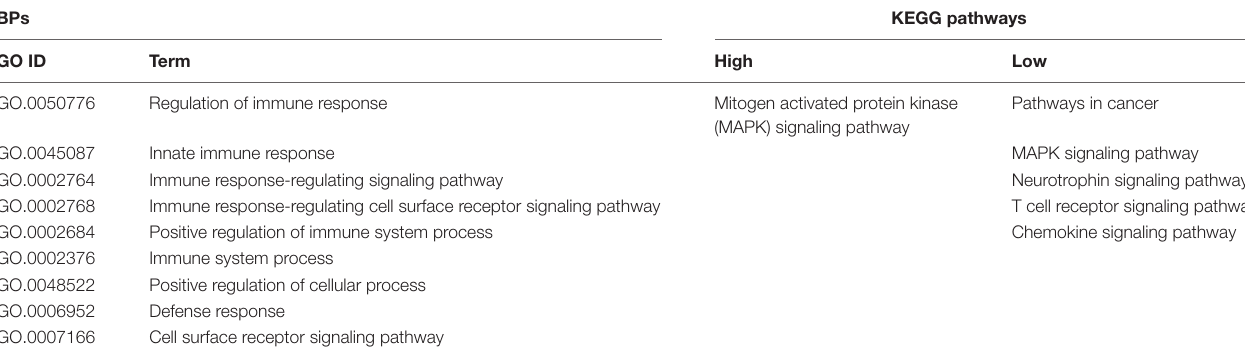
TaBle 5 | Gene ontology (GO) biological process (BP) terms and Kyoto Encyclopedia of Genes and Genomes (KEGG) pathways identified by the antibody array. BPs Kegg pathways gO